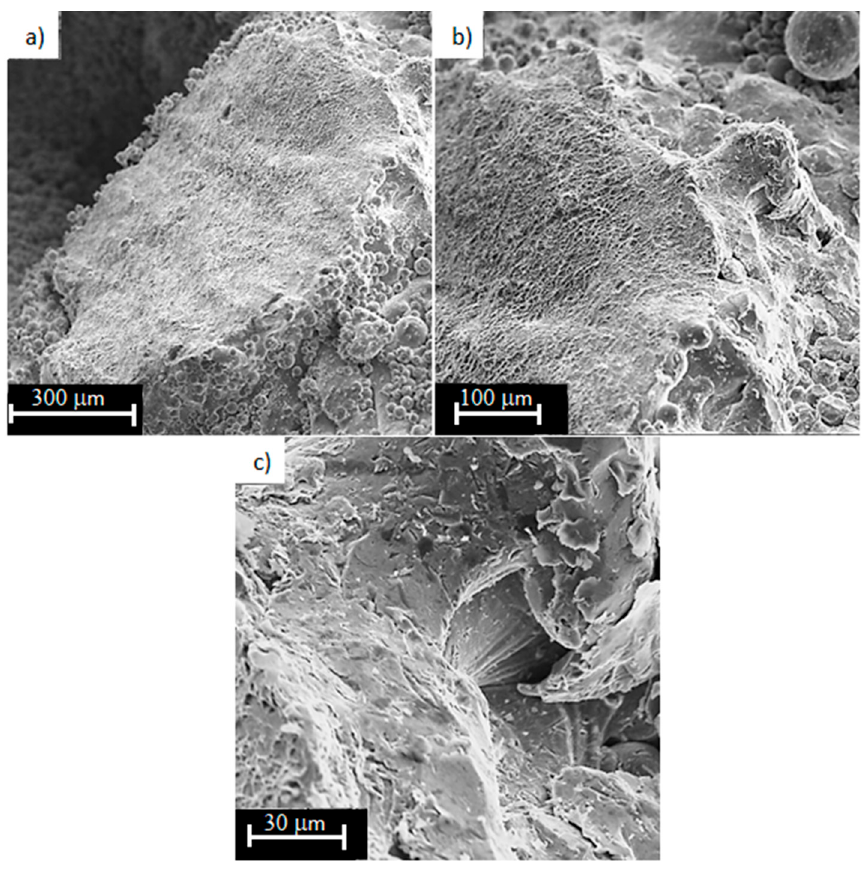
Figure 13. Fracture surfaces of Ti6Al4V titanium alloy with 34% porosity, subjected to a monotonic tensile test (magnification: ( a ) 250×; ( b ) 500×; ( c ) 2000×).